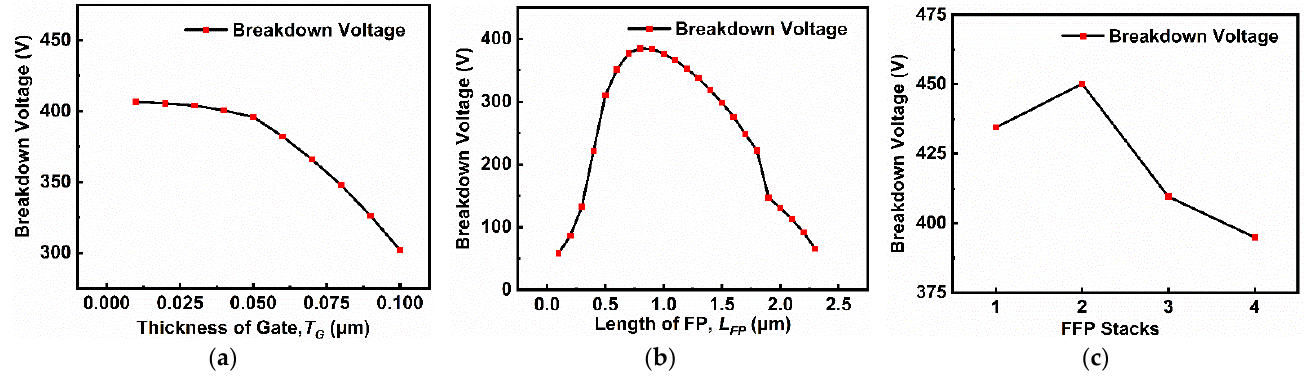
Figure 2. BV varies as a function of ( a ) T G , ( b ) L FP , and ( c ) nFFP. The optimum length of the field plate is required to achieve the maximum BV with a constant T G at the optimum value (i.e., T G = 0.05 μ m). The result in Figure 2b implies that the modulation of L FP is actually a balance process. The field distribution along with the 2DEG consists of two electric field peaks near the drain-side edge of the gate and the field plate. The short L FP causes the electric field peak in the edge of the gate dominating the electric field intensity along the 2DEG. In contrast, the field plate ’s edge appears to have a high electric field peak. The BV firstly presents a rise then a falling trend with the L FP increasing which directly indicates the optimum L FP of 0.8 μm.